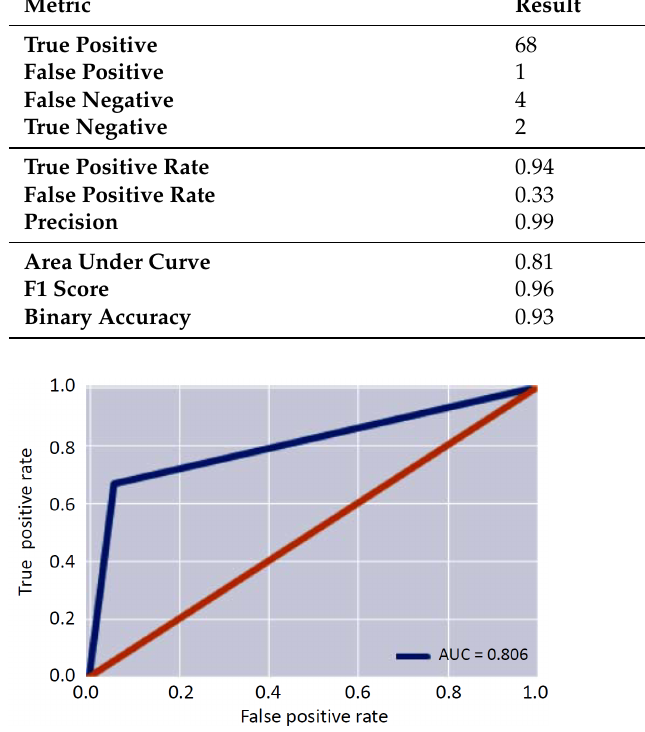
Figure 7. Area under the